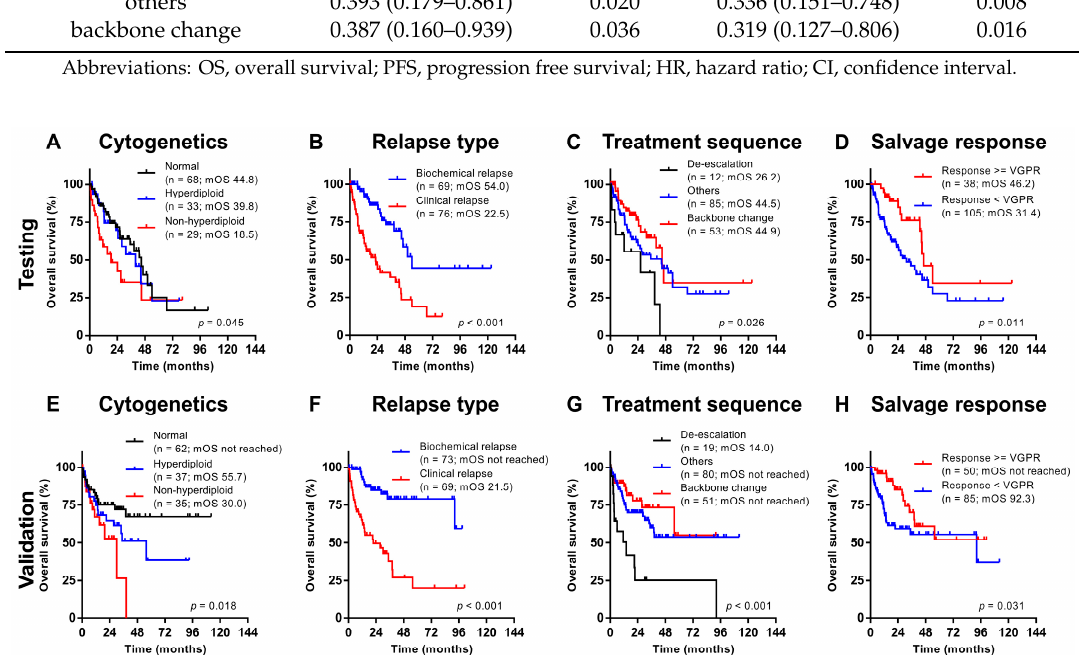
Figure Figure 3. Overall survival categorized according to different prognostic factors in the testing (( A ) cytogenetics; ( B ) relapse type; ( C ) treatment sequence; ( D ) salvage response) and validation (( E ) cytogenetics; ( F ) relapse type; ( G ) treatment sequence; ( H ) salvage response) cohorts.